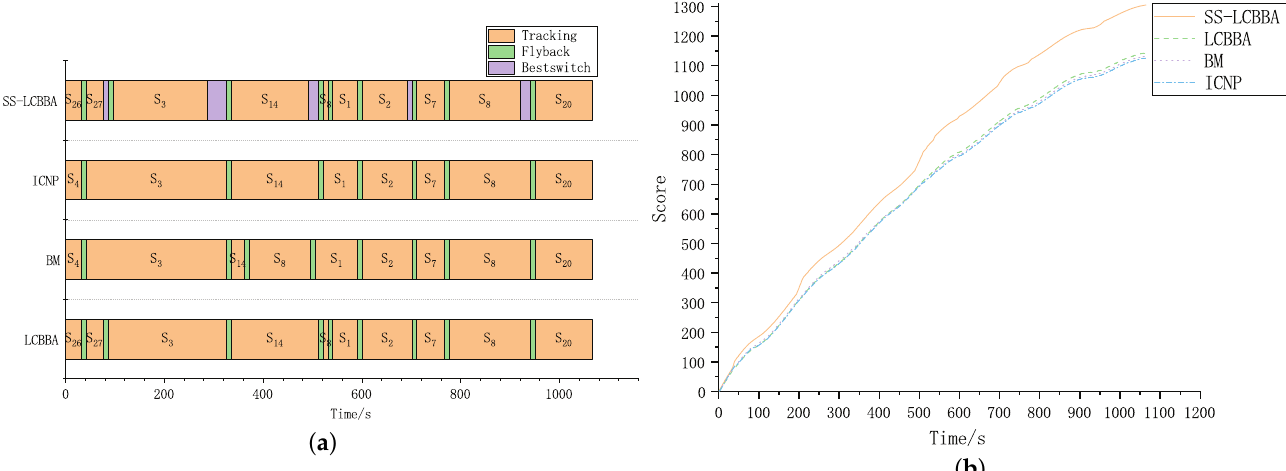
Figure 13. The planning results of tracking trajectory 1: ( a ) is a Gantt chart comparing the planning results and ( b ) is the cumulative tracking score of the value